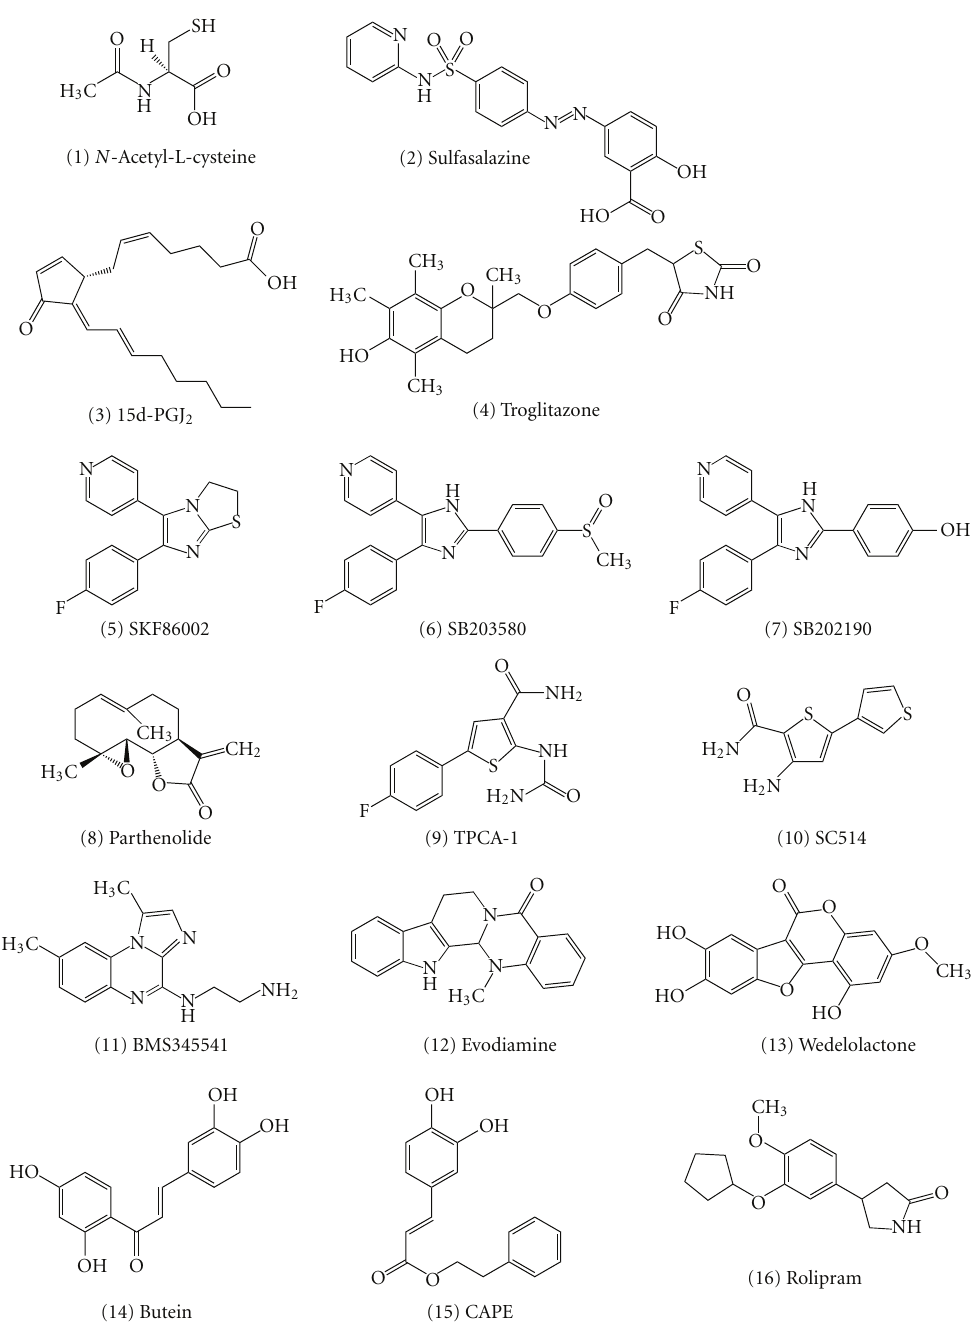
Figure 3: Pharmacological agents with inhibitory e ff ect on the production of proinflammatory cytokines by human fetal membrane cells.